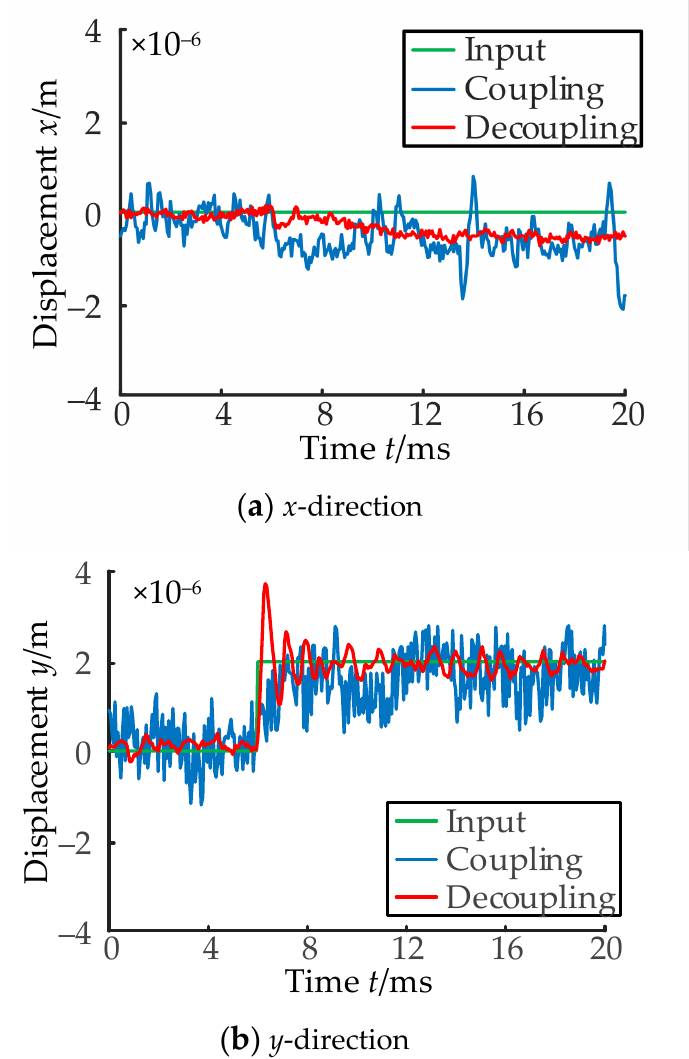
Figure 24. Displacement under step signal in channel y.